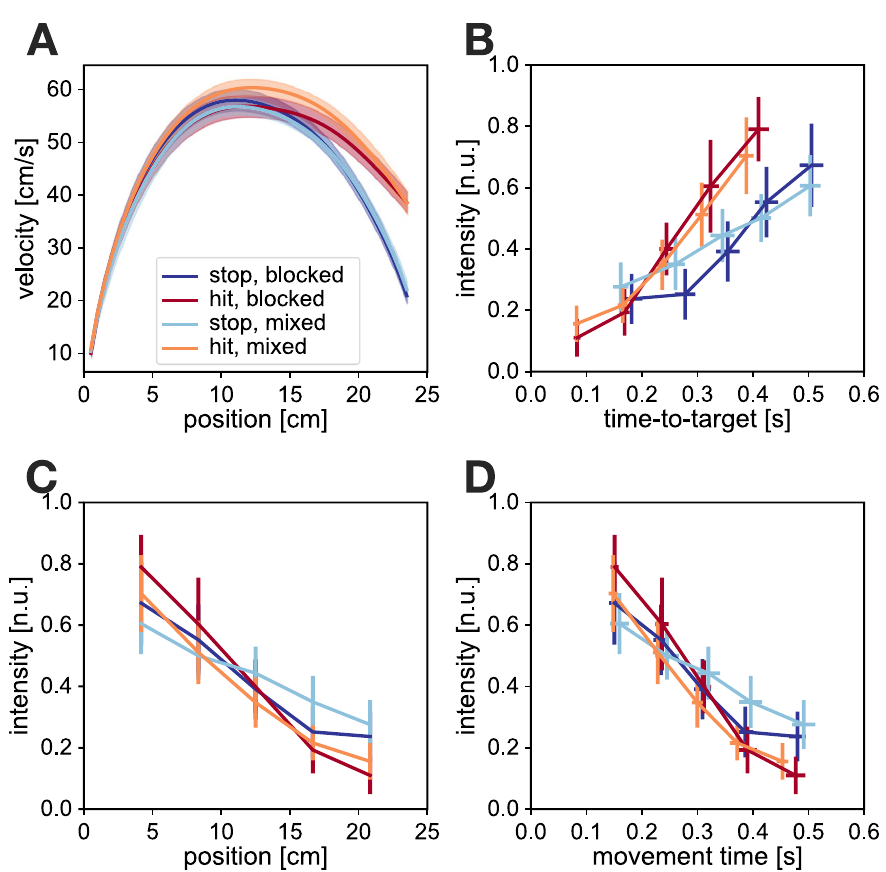
Fig 4. Experimental results of stop and hit conditions in both blocked and mixed schedules. A . Velocity profiles against position. Both stop conditions and both hit conditions produce respectively similar velocity profiles, showing that participants successfully performed the task in the mixed schedule. B . Normalised feedback response intensities represented as a function of time-to-target. Hit and stop movements in the mixed schedule demonstrate differences when expressed against time-to-target, that match the differences between hit and stop conditions in the blocked schedule. This supports the hypothesis of contextual controller switching between multiple task-specific controllers. C . Normalised feedback intensities in all four conditions show no differences when expressed against position or D . movement time at perturbation onset, as predicted by the OFC simulations. This questions the appropriateness of position or movement time as the reference frames in which to compare multiple feedback controllers. Error bars and shaded areas indicate 95% confidence intervals of the